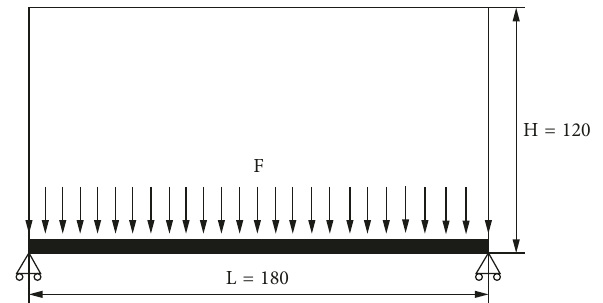
Figure 9: Design space of the through arch bridge.